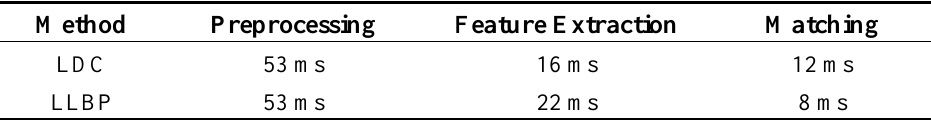
Table 3. The average preprocessing time for the LDC